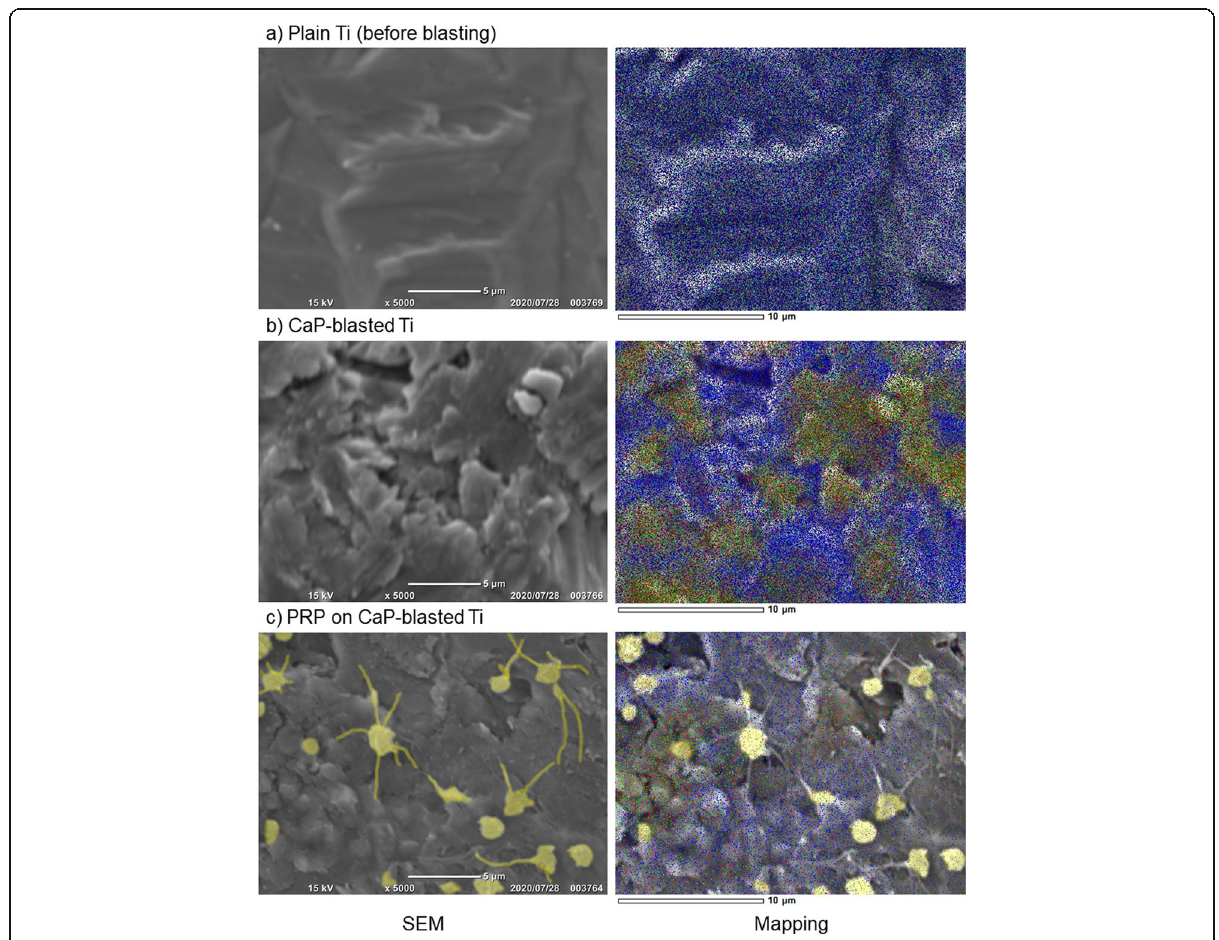
Fig. 3 Elemental mapping of plain and CaP-blasted cp-Ti plate surfaces. The a plain and b CaP-blasted cp-Ti plates were directly subjected to mapping. c Alternatively, after treatment with PRP for 60 min, the plates with adherent platelets were fixed, dehydrated, and examined using EDS. Blue, red, and green dots represent Ti, Ca, and P, respectively. Adherent platelets are faint